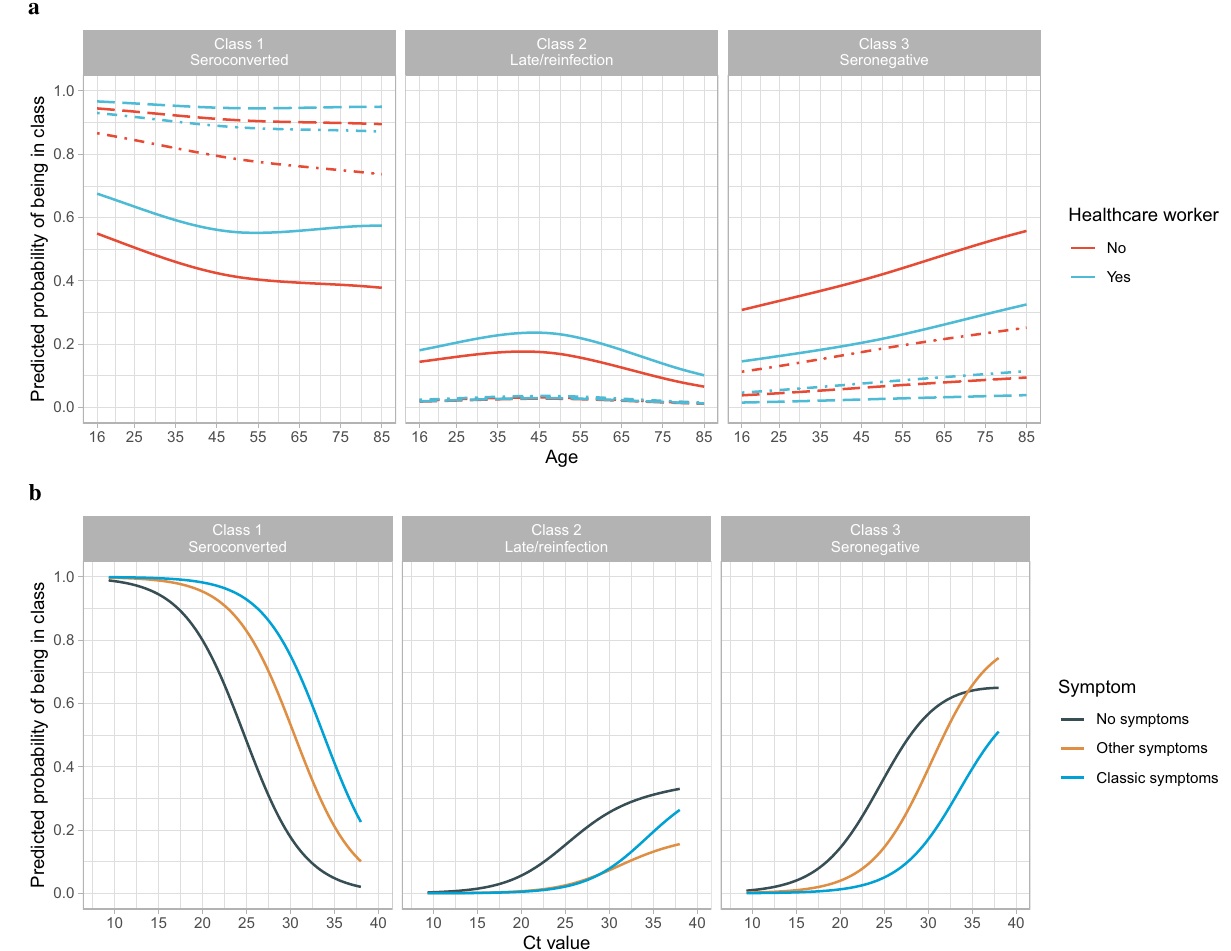
Fig. 2 Predicted probability of being in Class 1 (seroconverted in response to infection), 2 (possible late/re-infection) and 3 (seronegative non- responders). a By age and working in patient-facing healthcare, plotted at the reference category for other variables (female, White ethnicity, no long-term health condition, Ct = 26, have only one positive swab test during the infection episode) and no symptoms (solid line), other symptoms (dash-dotted line), classic symptoms (dashed line). b By Ct value and self-reported symptoms, plotted at the reference category for other variables (47-year-old, female, White ethnicity, no long-term health condition, not working in patient-facing healthcare, have only one positive swab test during the episode). Age was fi tted using natural cubic spline with one internal knot placed at 50 years and two boundary knots at 20 and 80 years. Full model results are shown in Supplementary Table